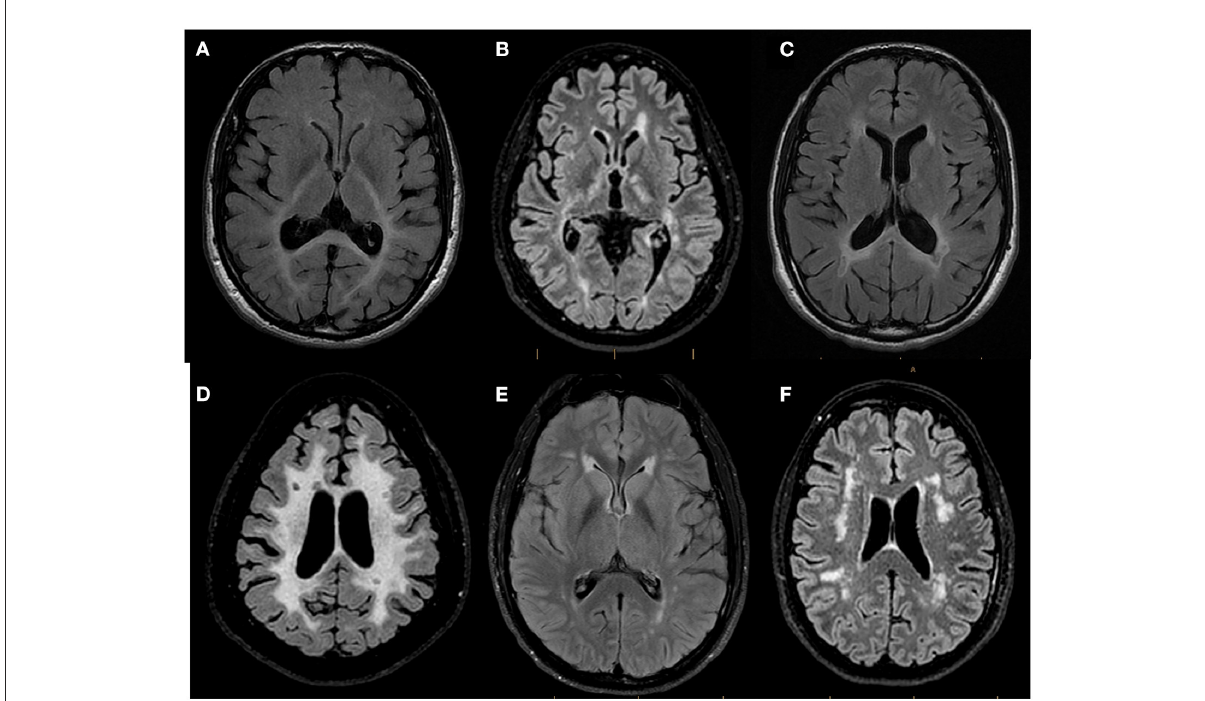
FIGURE3 Representative Brain MRI of patients referred to the WM Rounds according to their pattern of involvement. Representative axial FLAIR T2-weighted brain MR images of patients referred to the WMR according to their pattern of involvement. (A) 44-year-old man finally diagnosed with Peroxisomal Biogenesis Disorder showing confluent symmetric white matter abnormalities predominant in the posterior regions and affecting the splenium of the corpus callosum and the posterior limb of the internal capsules; (B) 29-year-old man diagnosed with X-linked Charcot-Marie-Tooth Disease and MS showing multifocal white matter lesions compatible with MS plaques; (C) 43-year-old man with suspected genetic MS mimicker showing bilateral periventricular white matter changes with involvement of the splenium of the corpus callosum and focal T2 hypointense lesions adjacent to the periventricular white matter; (D) 44-year-old man (no final diagnosis) with confluent symmetric white matter involvement in which focal T2-hypointense lesions suggestive of MS plaques were identified; (E) 38-year-old man with